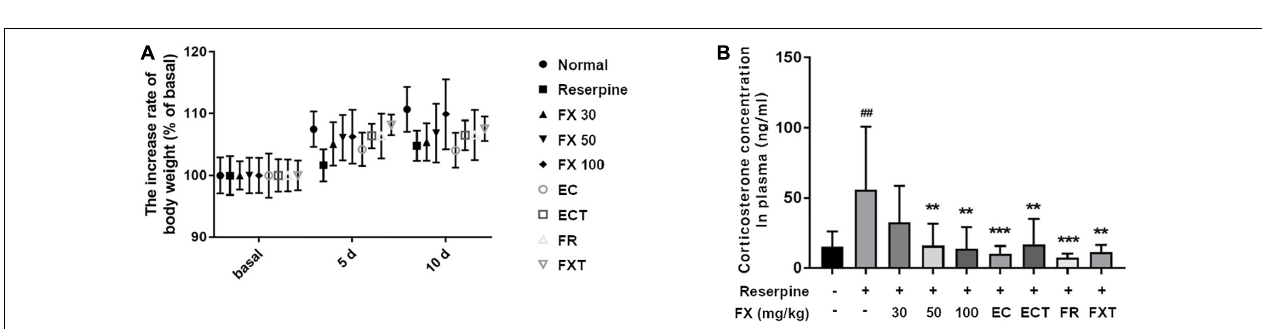
FIGURE 4 | Effect of FX extract and its components on body weight and plasma corticosterone concentration. The (A) body weight ( n = 8) and (B) plasma corticosterone concentrations ( n = 8) of the mice were measured. FX extract tended to increase body weight. FX extract, EC, ECT, and FR significantly decreased corticosterone concentration in the plasma. = 8. ## P < 0.01 vs. normal group; ** P < 0.01 and **** P < 0.0001 vs. reserpine group.